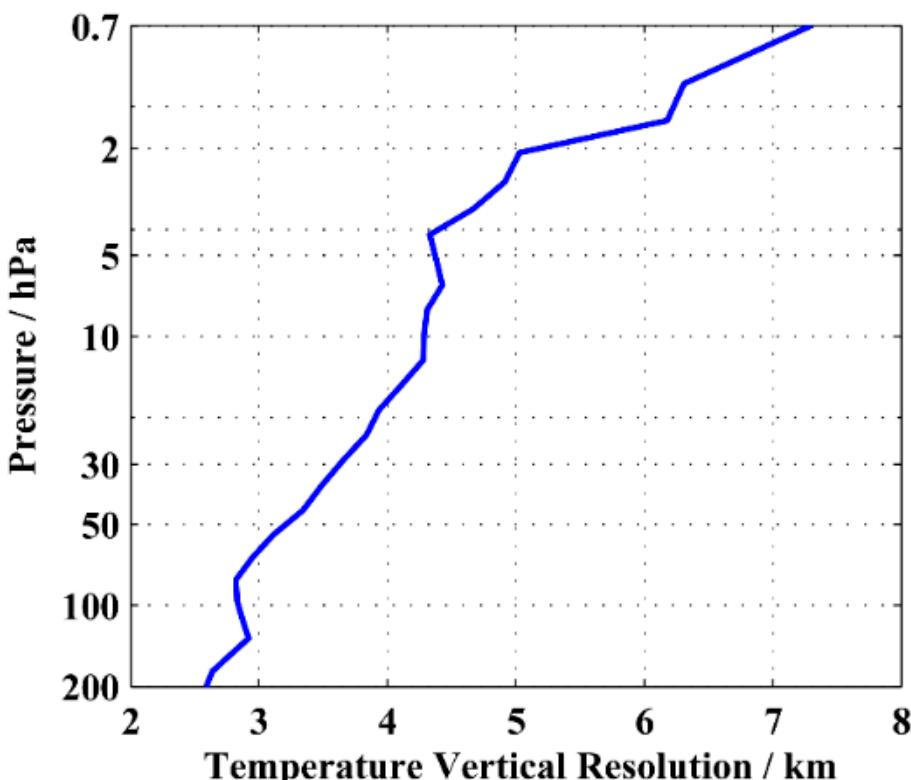
Figure 16. The vertical resolution of the joint-sounding with two narrow bands.